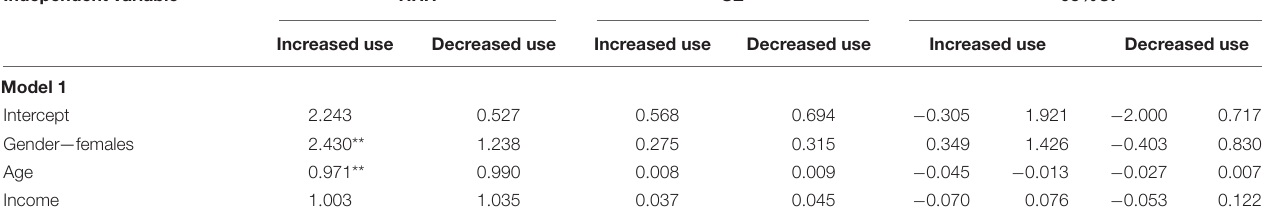
TABLE 4 | Change in frequency of use of urban green spaces during the COVID-19 lockdown explained by sociodemographic and green space characteristics variables. Independent